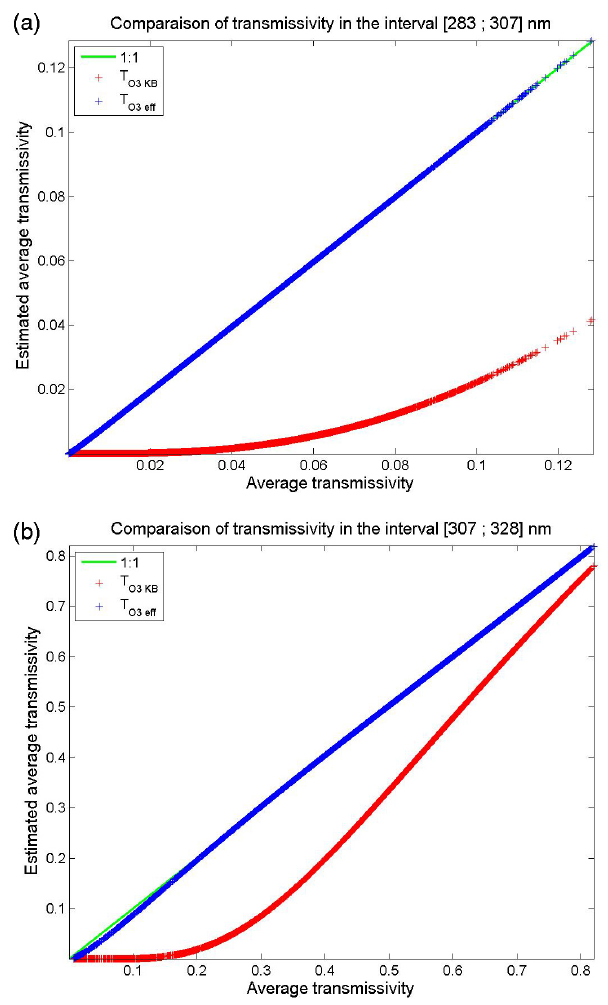
Figure 3. Scatterplot between average transmissivity T o3 (cid:49)λ and the estimated T o3 (red line) and T o3 (blue line) for (a) KB #3 [283, KB new 307]nm and (b) KB #4 [307, 328]nm. The identity line is in green.